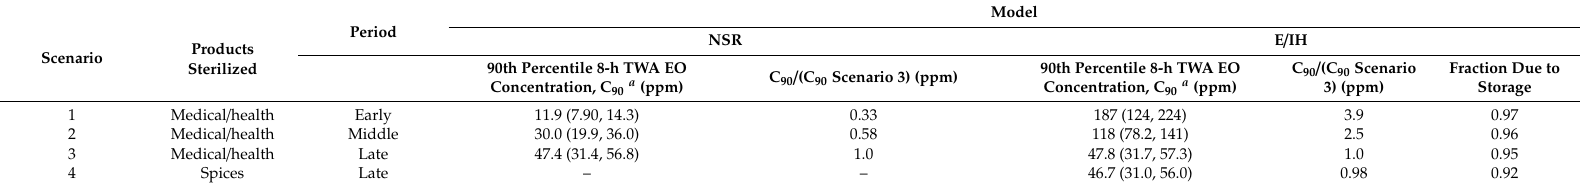
Table 4. Comparison of E / IH and NSR model